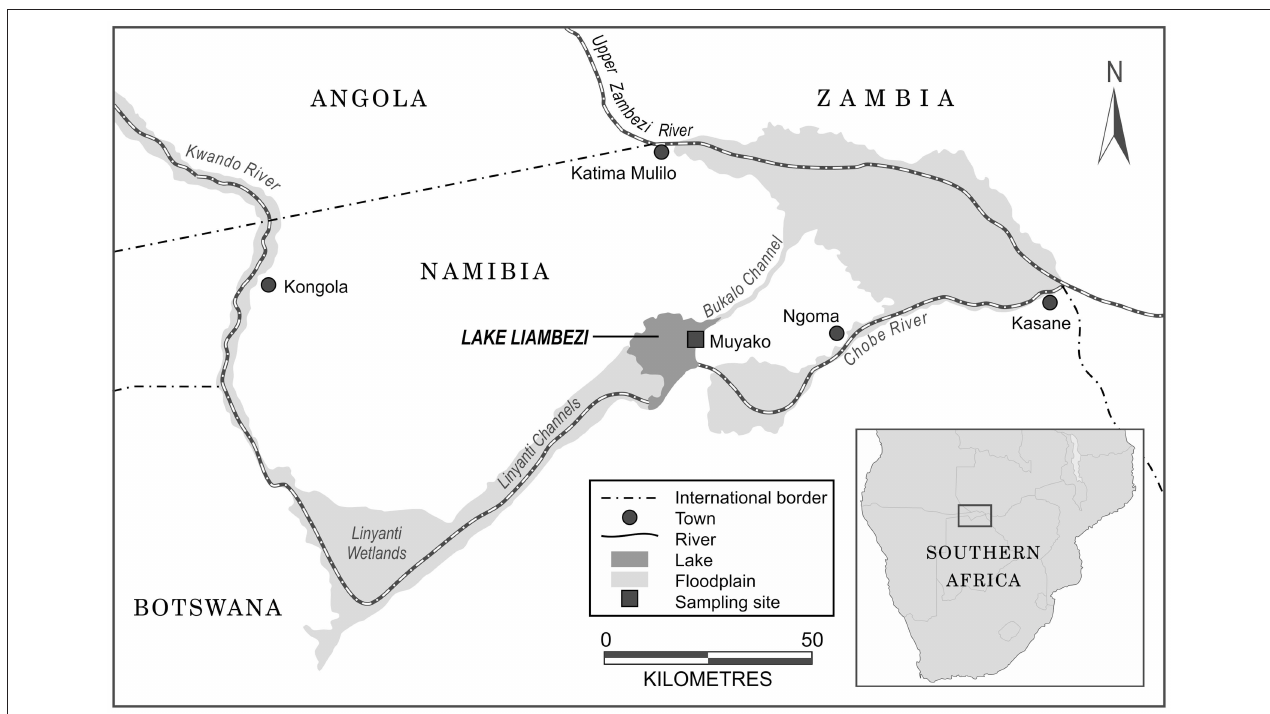
FIGURE 1 | Map of north-eastern Namibia illustrating the rivers and floodplains feeding into Lake Liambezi, and the location of the Lake Liambezi sampling